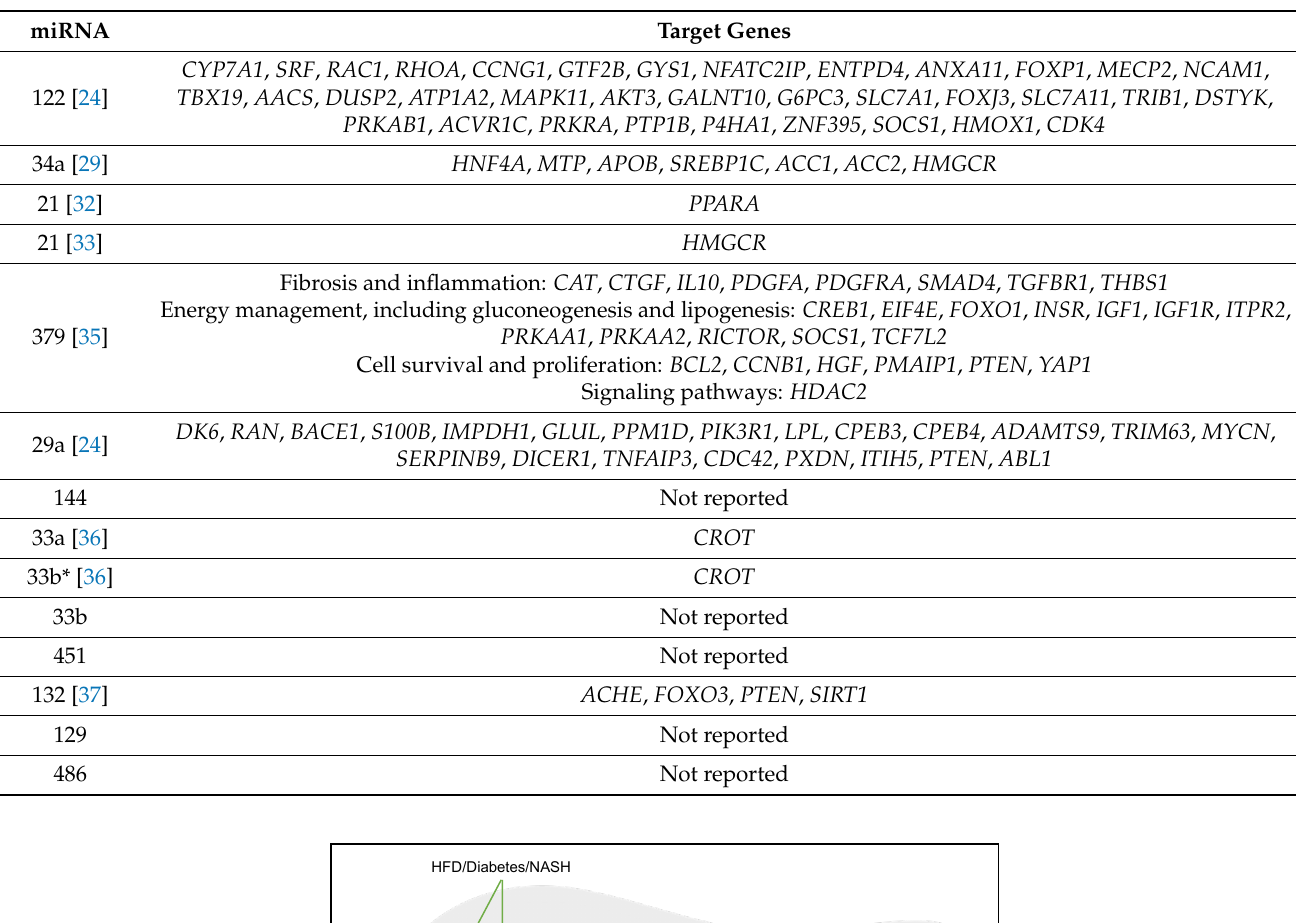
Table 1. miRNAs and their target genes.